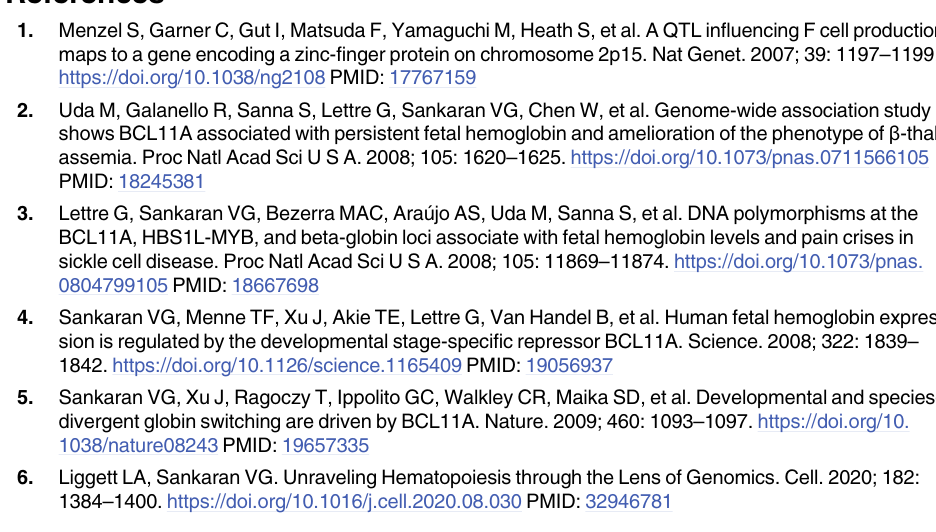
S1 Table. Oligos for Site Directed Mutagenesis for BCL11A mutant constructs and qPCR primer sequences used for checking of chromatin binding events and gene expression. S2 Table. Western blot and Flow cytometry antibodies. S3 Table. Pathogenic de novo deletion, loss-of-function, and missense variants impacting BCL11A with HbF levels